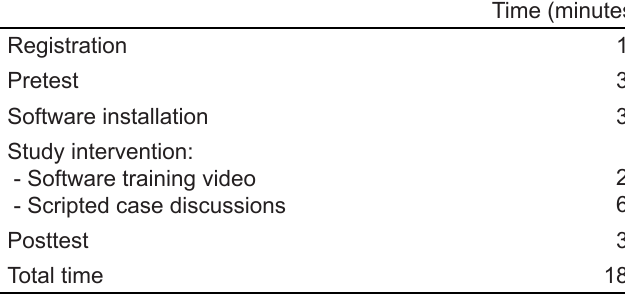
Table 1. Agenda and schedule for each 3-hour training session